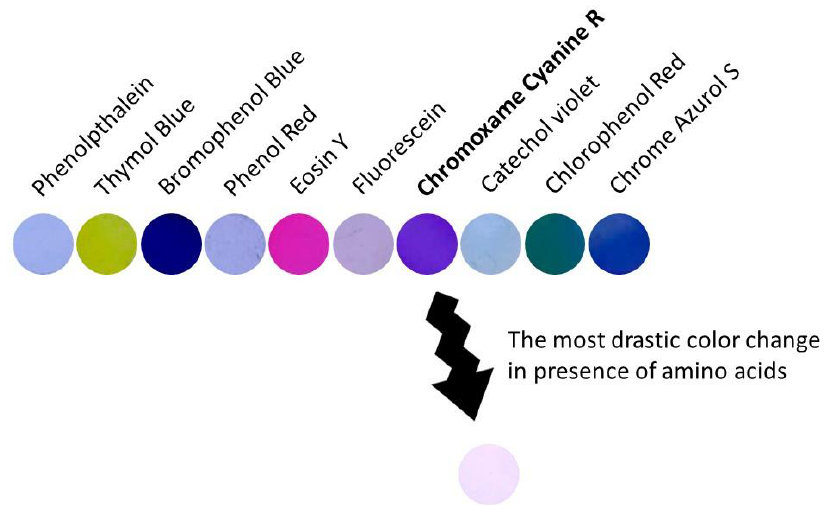
Figure 1. Ten discs (8 mm of diameter) of F (3)-Cu after immersion in solutions of different dyes.